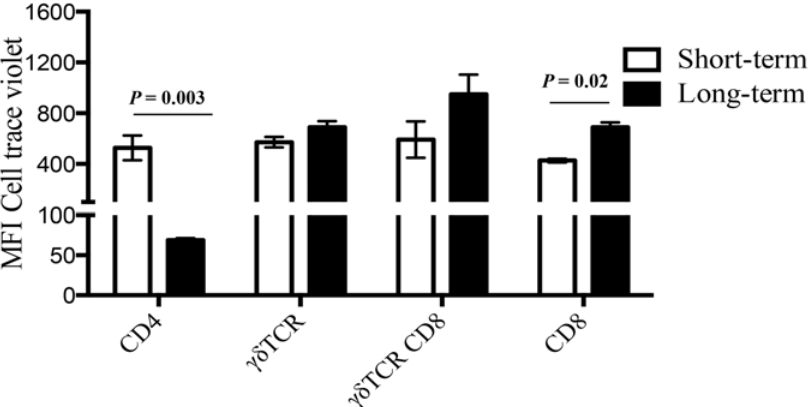
Fig 5. Proliferation of cell subsets in response to mycobacterial antigens. Approximately 7 weeks after M . bovis challenge, PBMCs from infected cattle were either long or short-term cultured (6 days). Long-term cells consisted of PBMCs cultured in the presence of rAg85A, rTB10.4, rESAT-6:CFP10 and PPDb for 13 days (n = 4). Subsequently, cells were stained with CellTrace violet dye and re-stimulated with either rESAT- 6:CFP10 or medium in the presence of APCs for an additional six days. Short-term cells consist of CellTrace Violet-stained PBMC from M . bovis -infected cattle cultured for six days in the presence of either rESAT-6: CFP10 or medium (n = 4). Proliferative responses of cells under both culture conditions were compared for each T cell subset. Data are presented as mean fluorescence intensity (MFI, y-axis) of CellTrace Violet for analysis of proliferation of T cell subsets (x-axis). Two-way ANOVA, n = 6, Š ídák ’ s multiple comparison post-